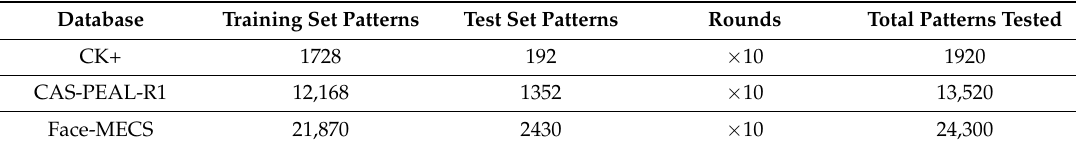
Table 2. Patterns contained in the training and test set using k-fold cross validation with k =